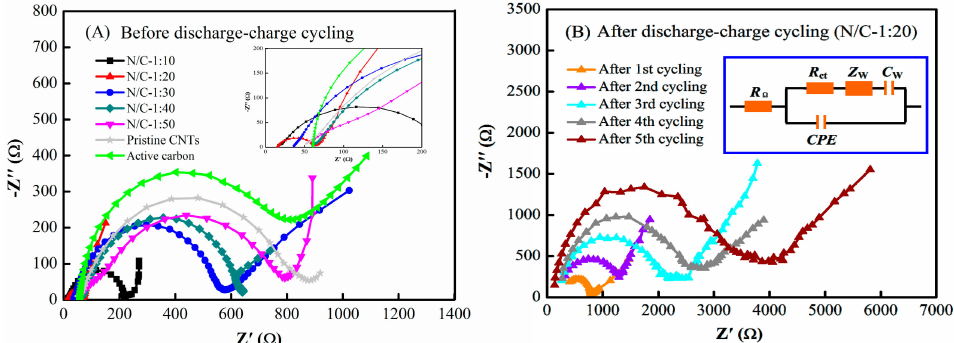
Figure 7. Impedance plots of Li–air batteries with ( A ) N-CNT arrays, pristine CNT arrays, and active carbon as air electrodes and the inset is the magnified impedance plots, ( B ) the N-CNT arrays with N / C feed ratio of 1:20 as the air electrode and the inset shows the corresponding equivalent